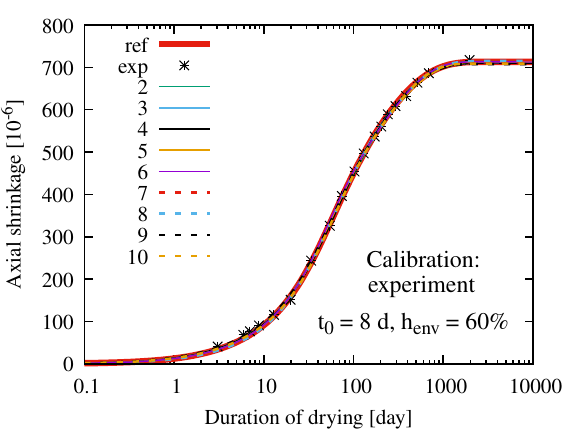
Figure 2. Dependence of di ff usivity on relative hu- midity for the 10 best fits in Fig. 1. In the legend f is the surface factor [mm/day].